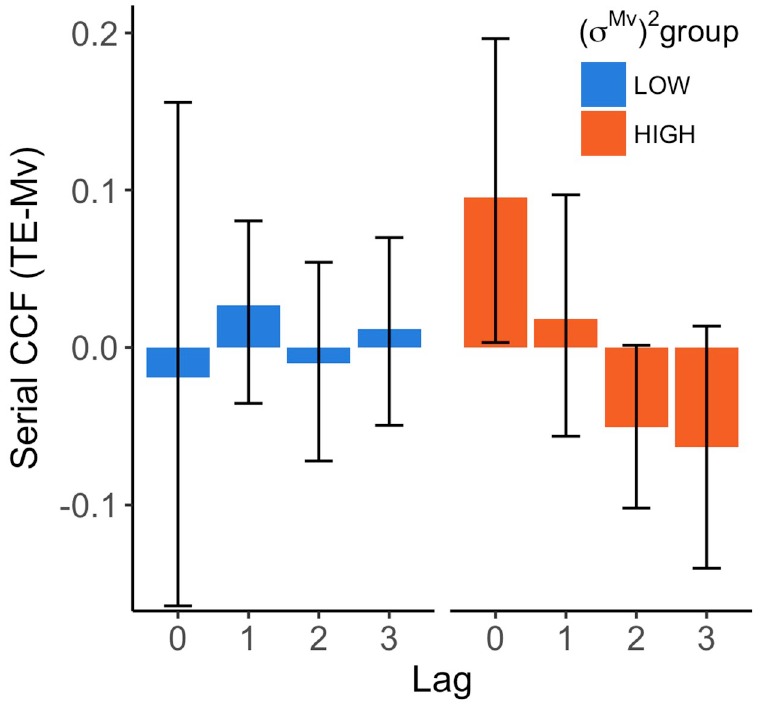
Fig 6. Serial ccf for each ( σ Mv ) 2 group. The serial ccf for lag 0-3 for the HIGH (orange) and LOW (blue) ( σ Mv ) 2 groups. The error bars represent the 95% bootstrapped confidence